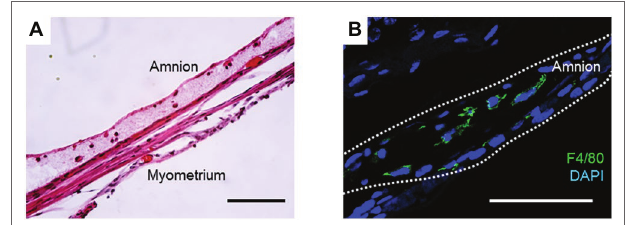
FIGURE 1 | (A) H&E staining of collagen-injected fetal membrane at ruptured site at 72 h. Note that a collagen gel layer was formed beneath the amnion, and immune cells were trapped inside the gel. (B) Immunofluorescence staining for F4/80 (green) and DAPI (blue) in the collagen layer at 48 h. Bars, 50 μ m. All animals were handled and euthanized in accordance with the standards of humane animal care described by the National Institutes of Health Guide for the Care and Use of Laboratory Animals, using protocols approved by the Institutional Animal Care and Use Committee (IACUC) of the University of Texas Southwestern Medical